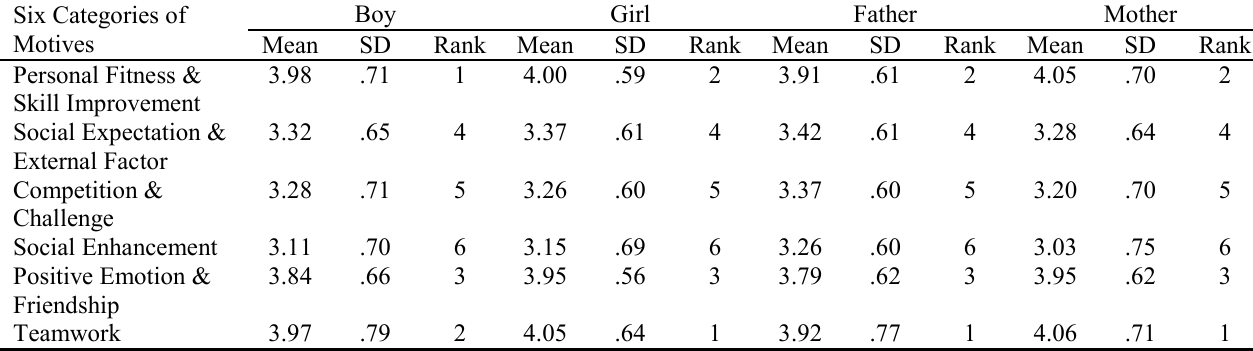
Table 3 Descriptive Data for Gender on the Revised Exercise Participation Motives Questionnaire Six Categories of